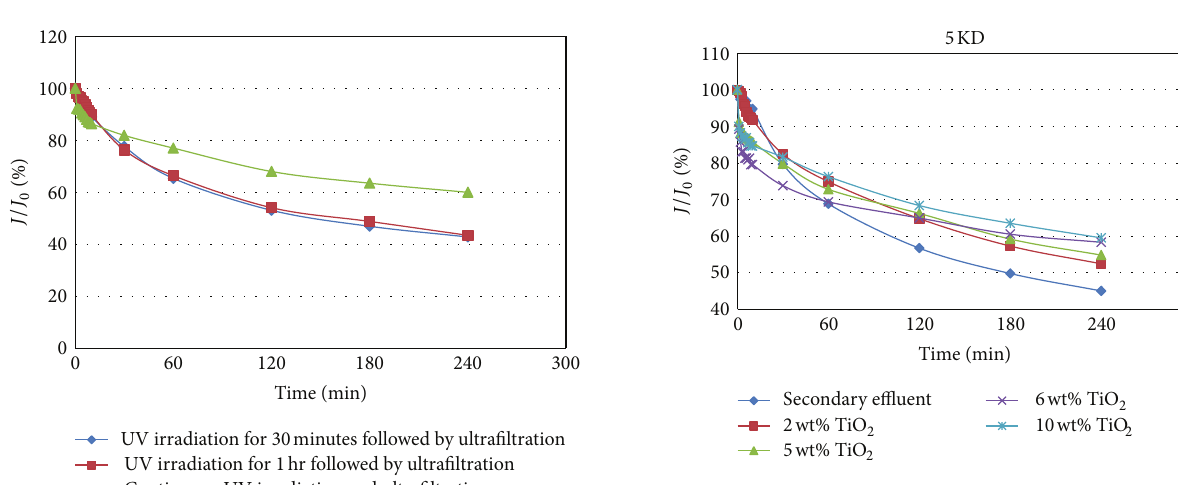
Figure 4: Effects of different TiO 2 concentration UV radiation on permeate flux during continuous UV radiation (5KD).